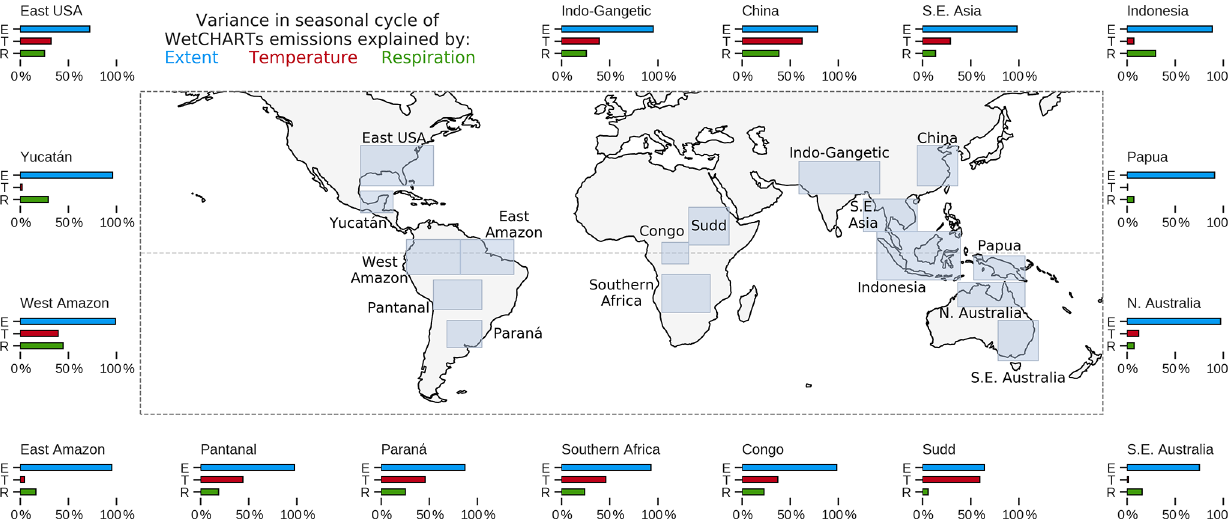
Figure 3. Explained variance ( R 2 ) calculated as the individual partial correlation between the seasonal cycle of the WetCHARTs CH 4 emissions and the seasonal cycles in the wetland extent fraction, temperature dependency and heterotrophic respiration for each region that were used to derive the WetCHARTs emissions. These values are averaged across all ensemble members to give an indicative value for the sensitivity of each region to the different driving parameters. Note that due to potential cross-correlations, it is not necessarily expected that the percentages sum to 100%.